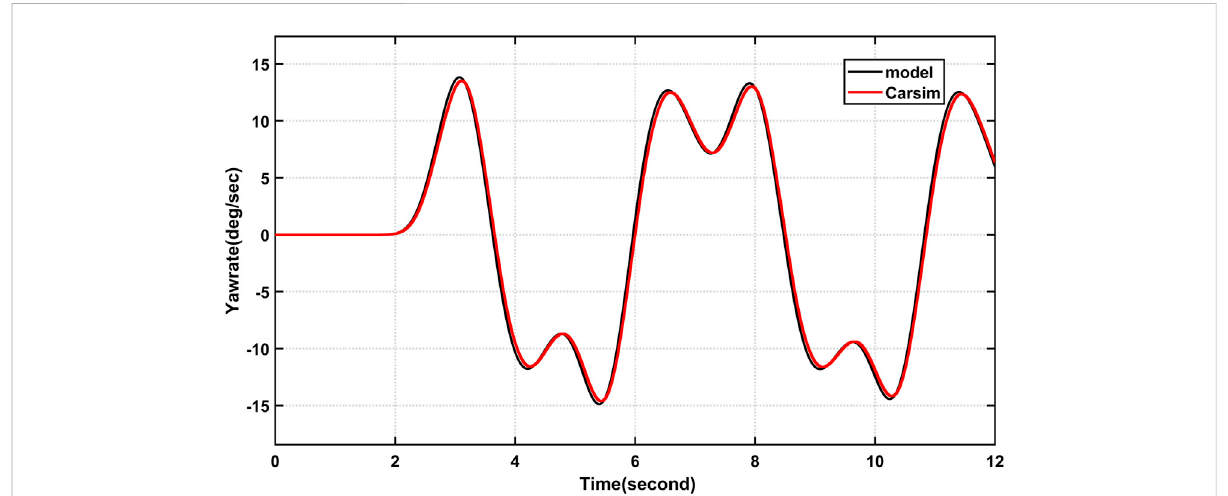
FIGURE 3 A comparison between the tricycle model that has been suggested and CarSim ’ s yaw rate.